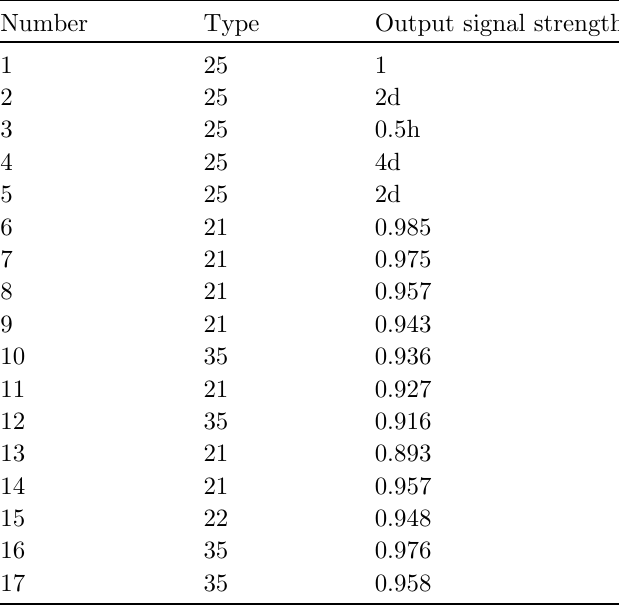
Table 4. Signal strength comparison of the logistics